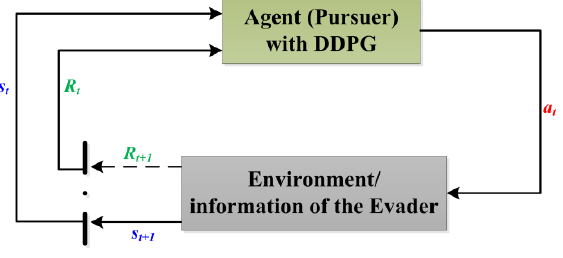
Figure 4. The agent-environment interaction in MDP.